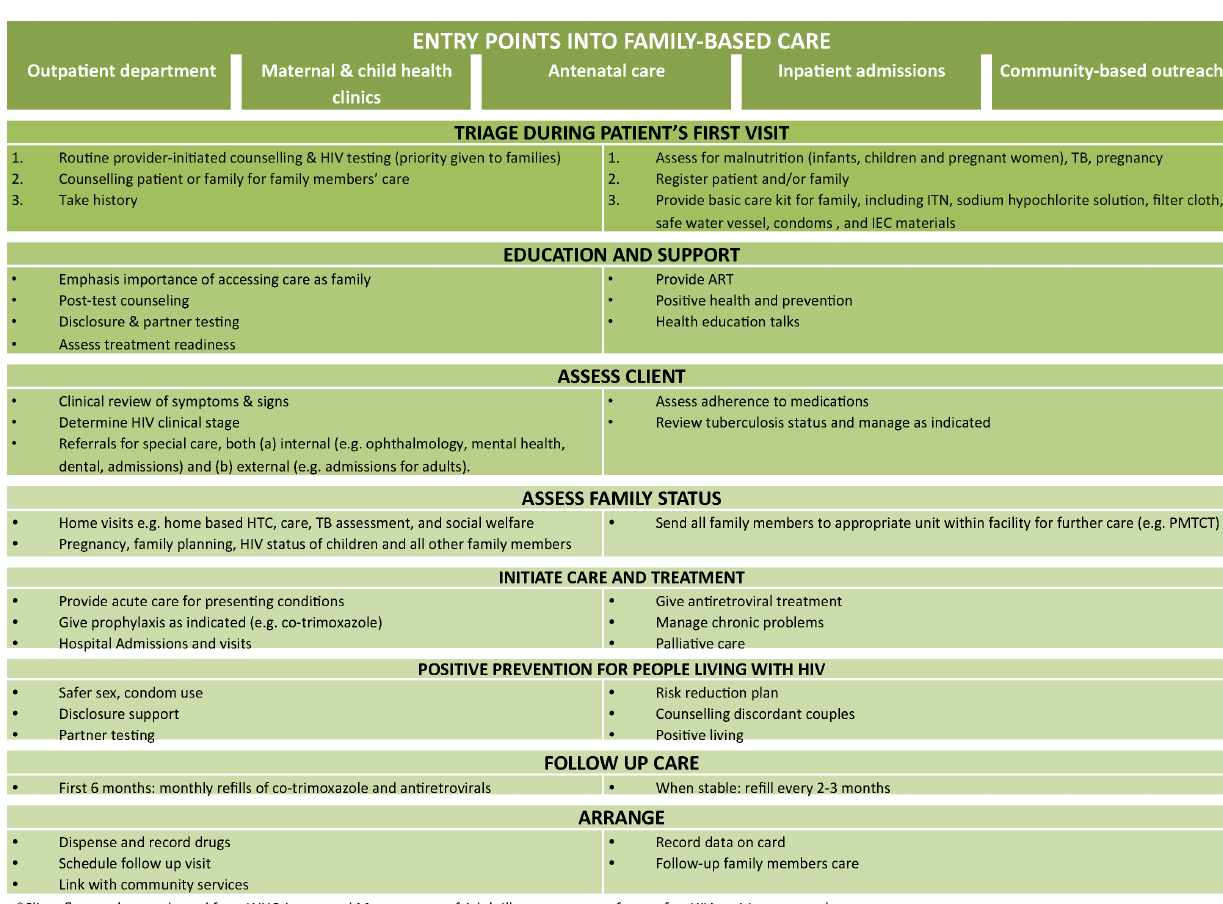
Figure 5. Client flow pathway into HIV care and treatment within family-centred approach. Figure demonstrates the patient flow at integrated facilities; the pathway has been adapted from the WHO Integrated Management of Adult Illness sequence of care. Entry points into family- based points including outpatient care, maternal and child health clinics, antenatal care, inpatient admissions, and community-based outreach. Clients then proceed through triage assessments, education and support as required, assessment of client and family health status, care and treatment as required, positive prevention for HIV-infected clients, and follow-up care services.